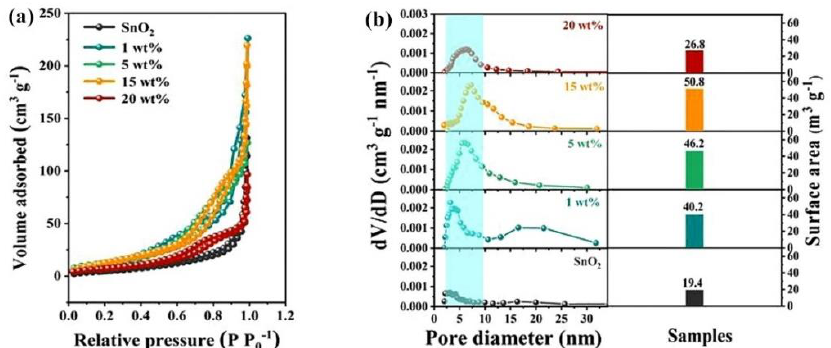
Figure 17. ( a ) N 2 adsorption-desorption isotherm; ( b ) pore size distribution and surface areas of pristine SnO 2 and ZZS HNFs with different Zn 2+ doping amounts [97].